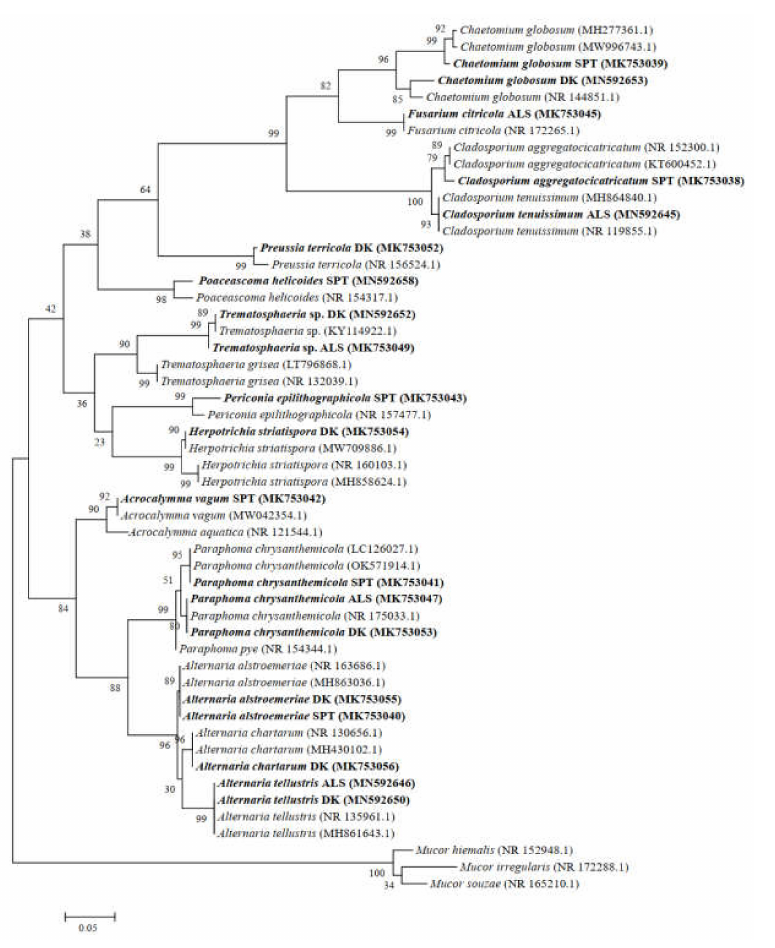
Figure 3. Maximum likelihood tree based on the ITS4-5.8S-ITS5 rDNA sequence analysis of DSEs isolated from roots of Artemisia ordosica . Sequences that were determined in the course of this study appear in bold.